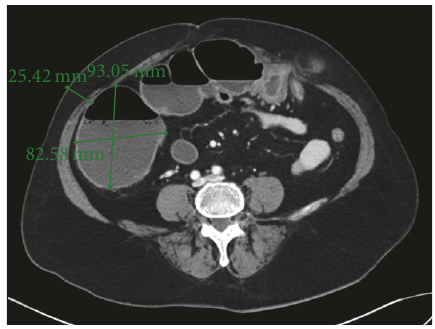
Figure 2: Axial CT showing significantly dilated caecum.